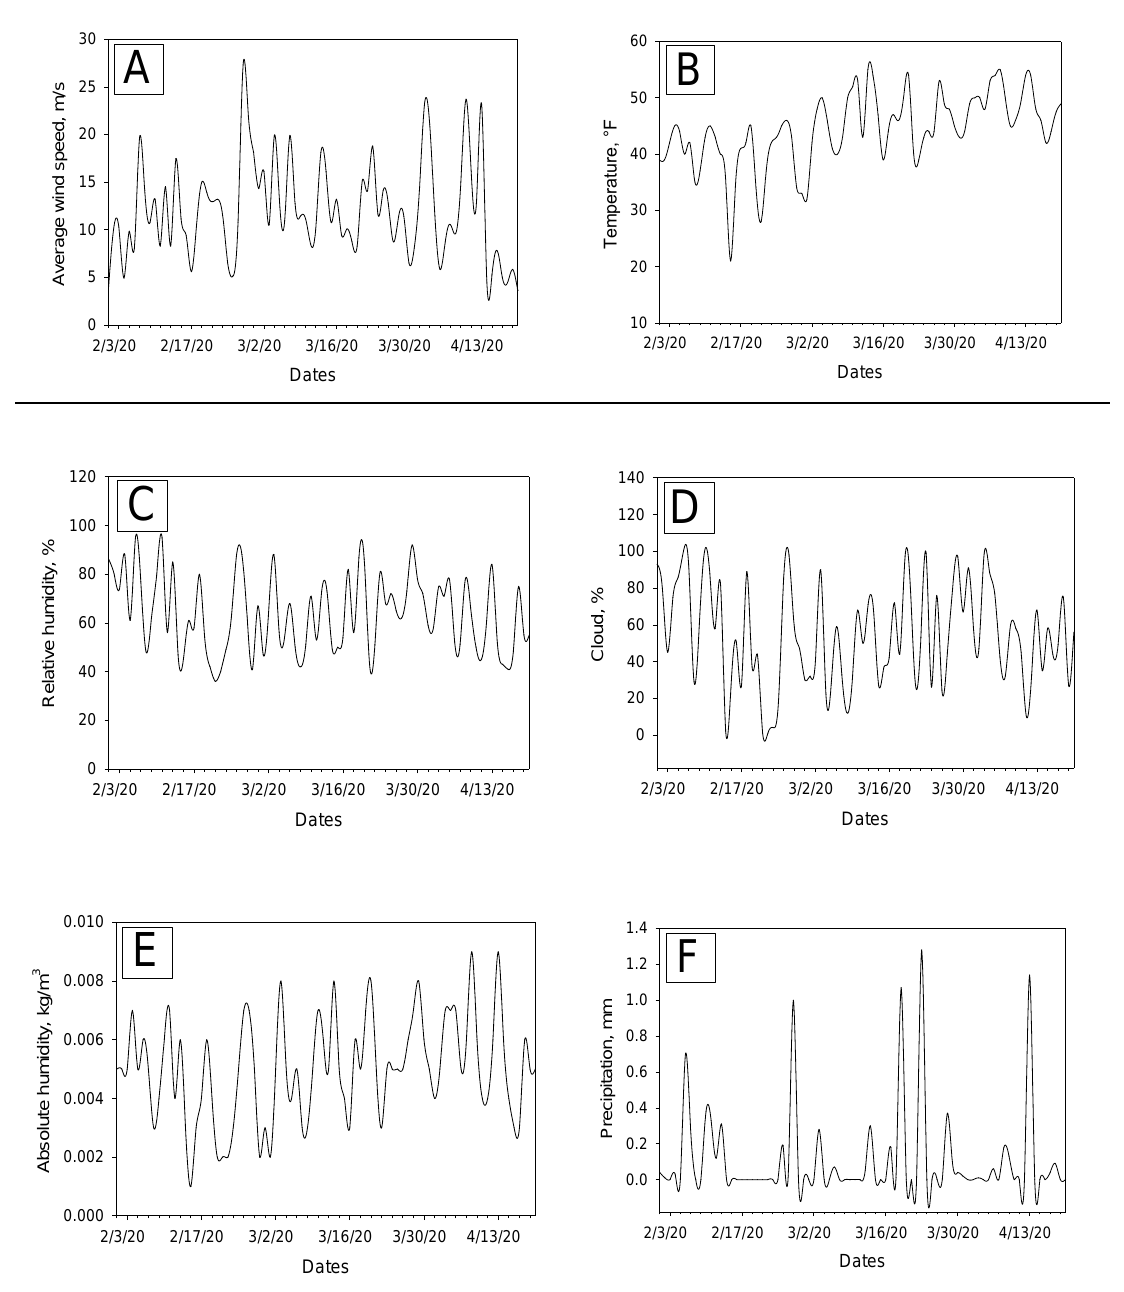
Figure 4. Daily variations of meteorological factors in Queens, New York between 1 February and 20 April 2020. ( A ) Wind speed; ( B ) Temperature; ( C ) Relative humidity; ( D ) Cloud; ( E ) Absolute humidity; ( F ) Precipitation.